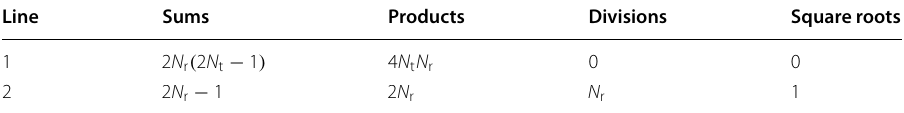
Table 2 Computational operations of reduced-complexity power algorithm Line Sums Products Divisions Square